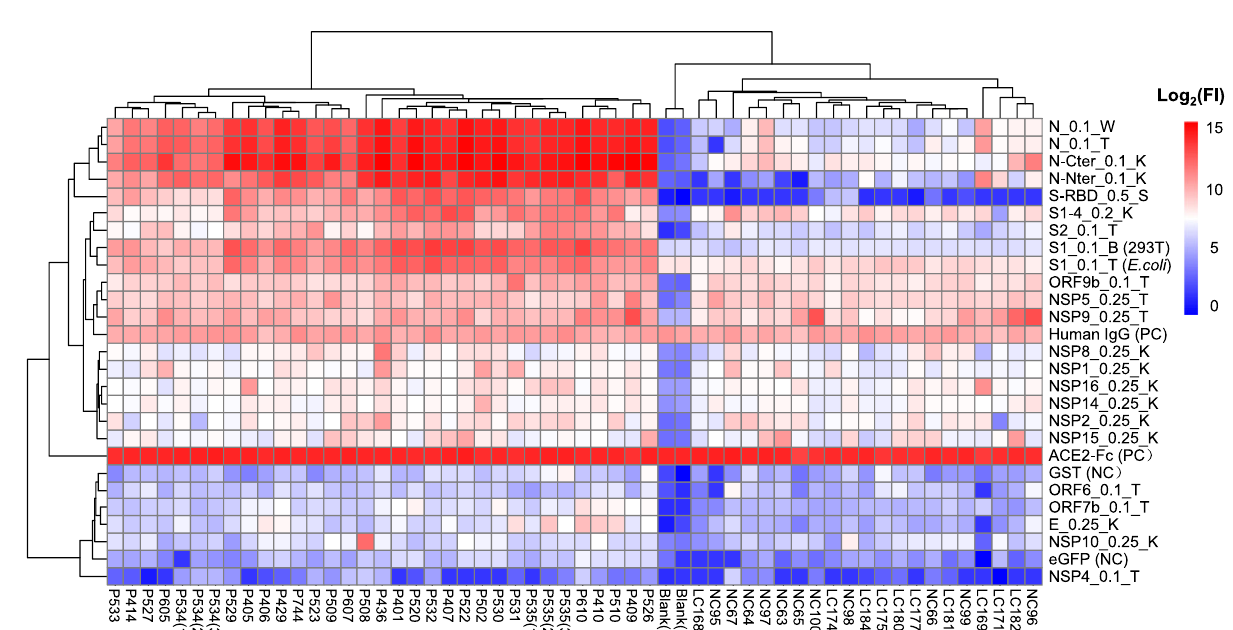
Fig. 3 The overall SARS-CoV-2-speci fi c IgG pro fi les of the 29 convalescent sera against the proteins. Each square indicates the IgG antibody response against the protein (row) in the serum (column). Proteins were shown with names along with concentrations ( μ g mL − 1 ) and sources. Sera were shown with group information and serum number. NCP Novel Coronavirus Patients or COVID-19 patients, LC lung cancer, NC normal control. Blank means no serum. Three repeats were performed for serum P534 and P535. FI fl uorescence intensity.